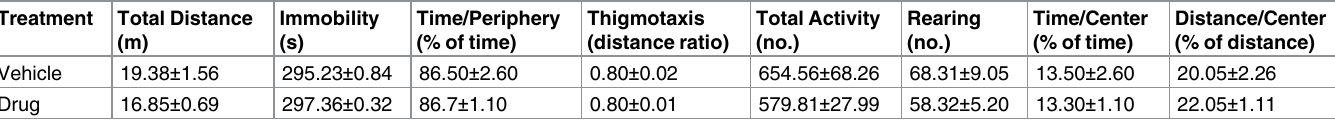
periphery zone, thigmotaxis, total activity, number of rearings, time spent in the center zone, and distance travelled in the center zone regardless of the treatment, genotype, or gender, indi- cating that no abnormal anxiety-like behavior was induced by vehicle or R121919 treatment (Table 1).